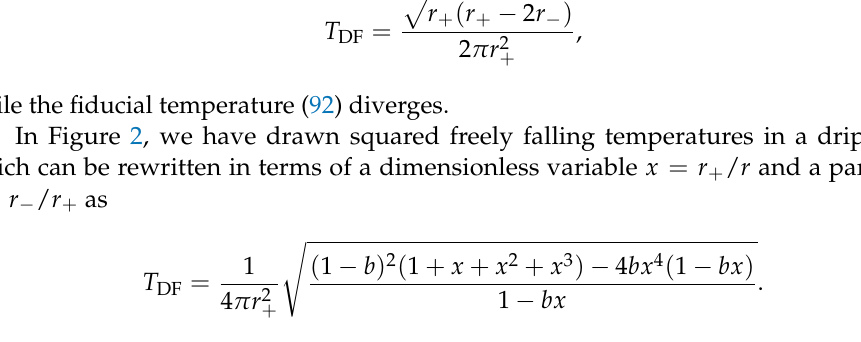
Figure 2. Squared freely falling temperatures in a drip frame, T 2 b = 0.2, 0.4, 0.5, 0.6, 0.9,and 1, where b = r − / r + . The dotted line at x = 1 is for the horizon r +